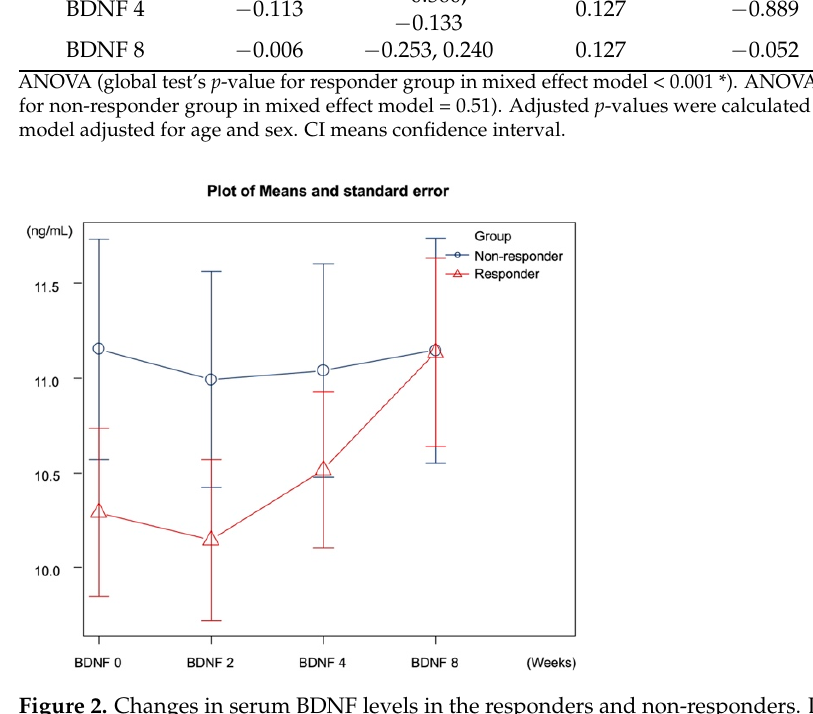
. Figure 3. Changes in serum BDNF levels in the responders (red column) and non-responders (blue column). Data was expressed as mean and standard error. ANOVA (global test’s p -value for inter- action analysis in mixed effect model; * p = 0.0025. 4. Discussion The results of the current study showed that serum BDNF concentrations increased significantly after 8 weeks in the paroxetine, escitalopram, and duloxetine response groups, but not after 2 or 4 weeks. However, serum BDNF concentrations did not increase at any point in time in the non-response group. We also found that serum BDNF levels at week 0 (baseline) did not statistically differ between the responder group and the non- responder group. Previous studies have reported that serum BDNF concentrations increased during antidepressant treatment [33,34,47,48]. However, the duration of the response and the